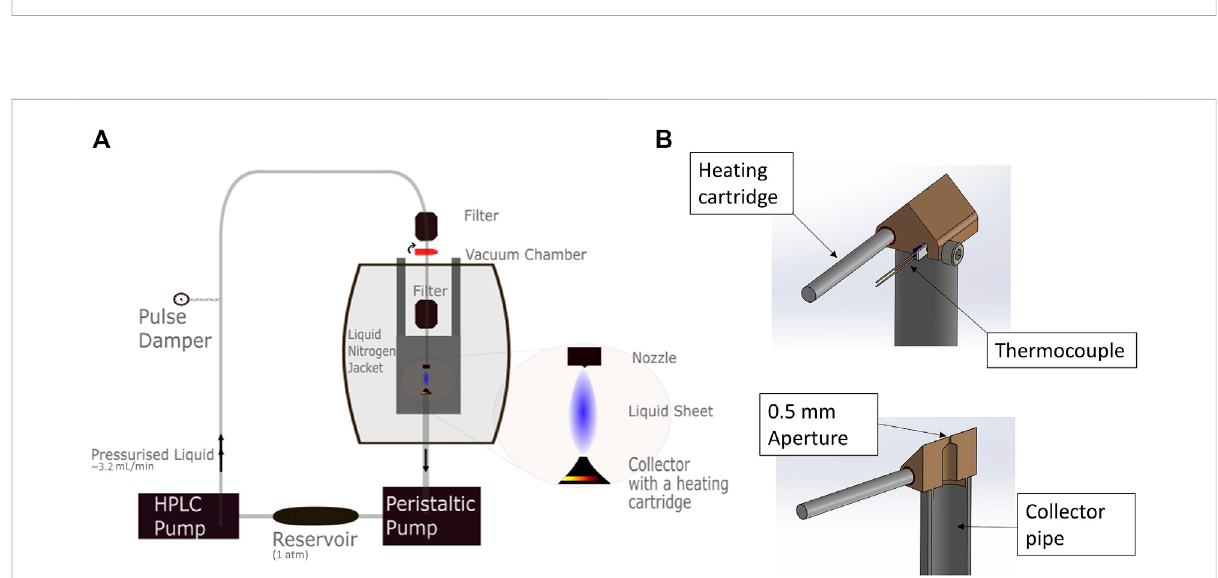
FIGURE 4 (A) Asketchofourrecirculatingsystem.TheliquidispumpedfromanatmosphericpressurereservoirbytheHPLCpumpintothenozzle,where itcreatesthesheet.Thecollectortipisheatedto60 ° bya25 Wheatingcartridge.Athermocoupleisattachedtothecollectortiptoensureaconstant temperature is maintained. The liquid is then pumped from vacuum to atmosphere by a peristaltic pump (Gilson Minipuls 3). The analogue